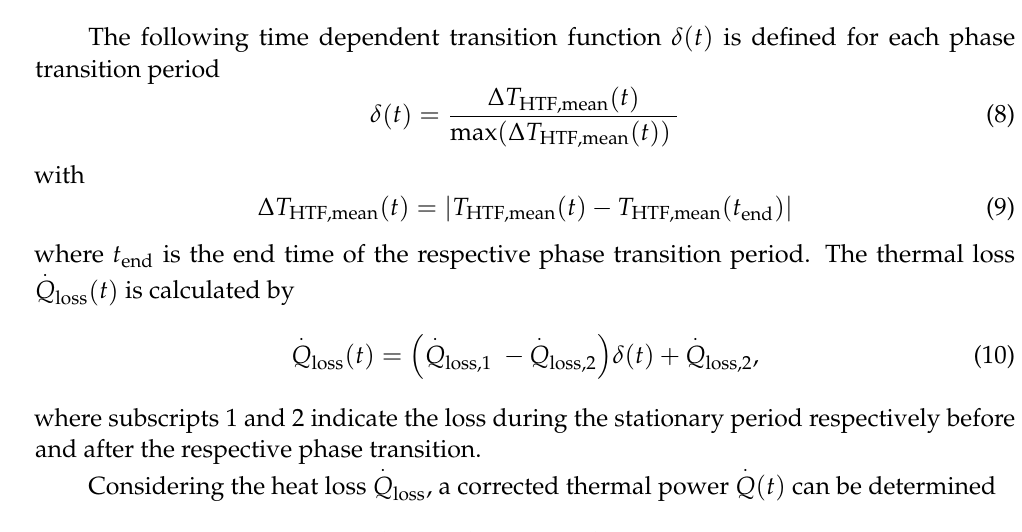
Figure 7. Inlet and outlet temperature for an experimental characterization during the three measurement periods initializa- tion, crystallization and